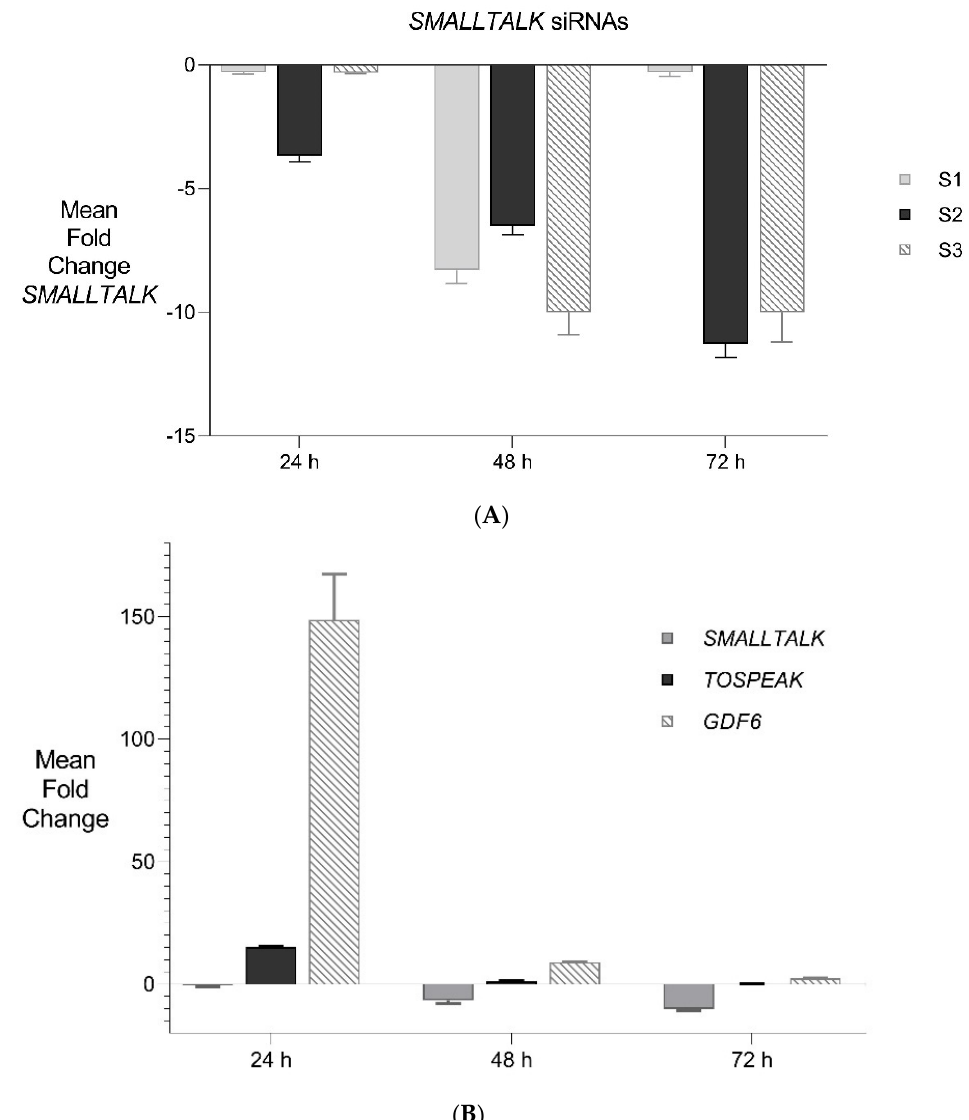
Figure 6. Expanded Application of Transient Transcriptional Interference. ( A ) Expanded siRNA Mediated Knockdown of SMALLTALK : Comparative rtPCR expression analysis of SMALLTALK in the normal human fibroblast cell line (NC1) over 72 h following separate exposure to siRNA-S1, siRNA-S2 and siRNA-S3 targeting SMALLTALK , respectively, expressed as the mean fold change of untreated control levels. ( B ) siRNA Mediated Transient Transcriptional Interference Assays: Comparative rtPCR expression analysis of TOSPEAK , GDF6 and SMALLTALK in normal human fibroblasts over 72 h following exposure to siRNA-S2 targeting SMALLTALK expressed as the mean fold change relative to the mean for untreated control levels.